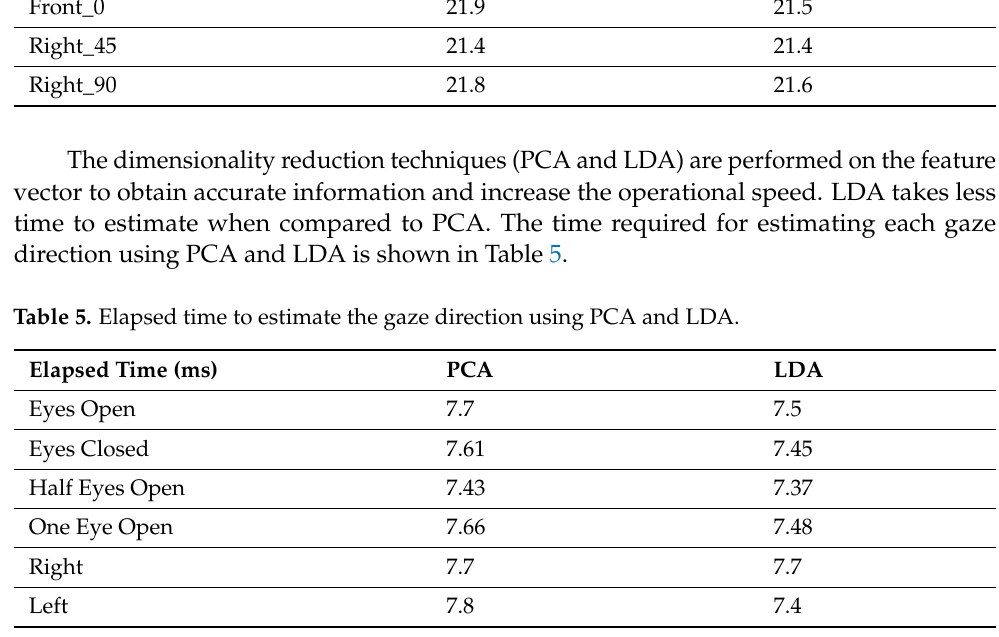
Figure 5. Estimation of gaze direction for varying illumination and occlusion conditions.